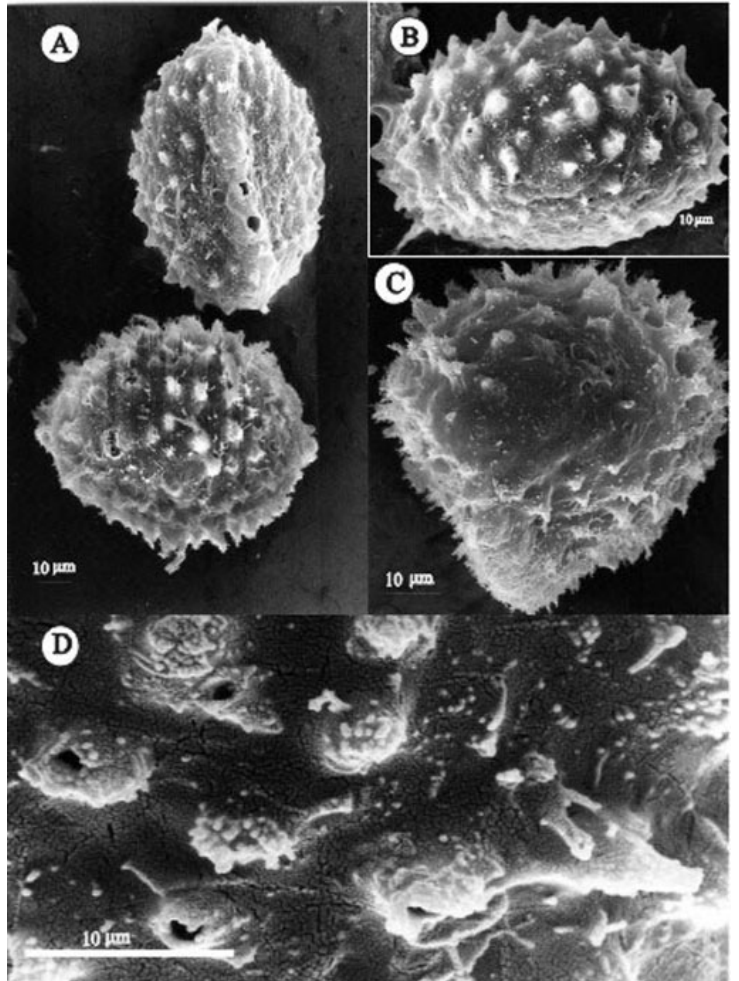
Fig. 3 – Isoetes pedersenii . A-D. Microspores observed with SEM. A – Proximal view (top) and equatorial view (bottom). B – Major equatorial view showing the echinate-tuberculate ornamentation. The echinae are higher and more densely distributed distally. C – Lower equatorial view showing the supra-laesural ex- pansion (Macluf et al. 2006a). D – Detail of the equatorial surface. The orna- mentation consists of cones distributed in the entire surface. Some cones show their apex broken. ( Pedersen 8105 ,